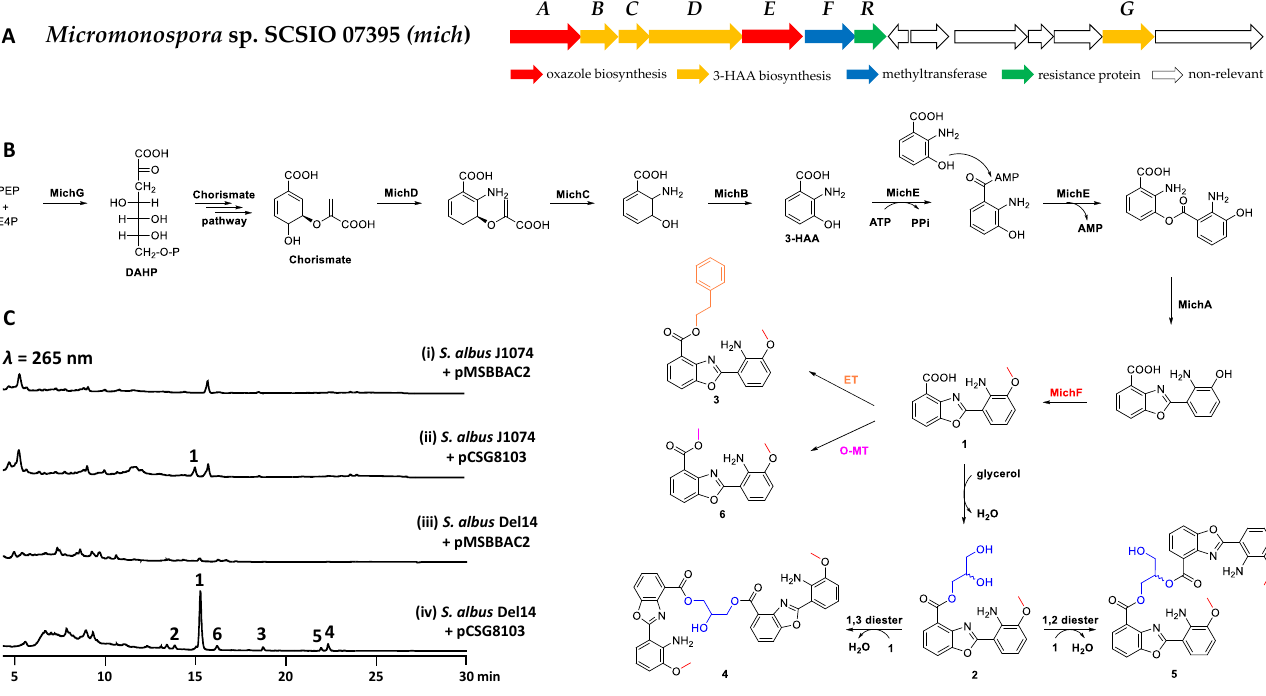
Figure 1. Biosynthesis of microechmycins. ( A ) The mich cluster identified from Micromonospora sp. SCSIO 07395. MichA, an amidohydrolase, MichB, a dehydrogenase, MichC, an isochorismatase, MichD, an anthranilate synthase, MichE, a coenzyme A ligase, MichF, a O-methyltransferase, MichR, a putative resistance-associated protein, MichG, a DAHP synthase. ( B ) Proposed biosynthetic pathway of microechmycins. ET: esterification, MT: methylation. ( C ) Product profiles from heterologous expression of mich BGC in S. albus J1074 and S. albus Del14.